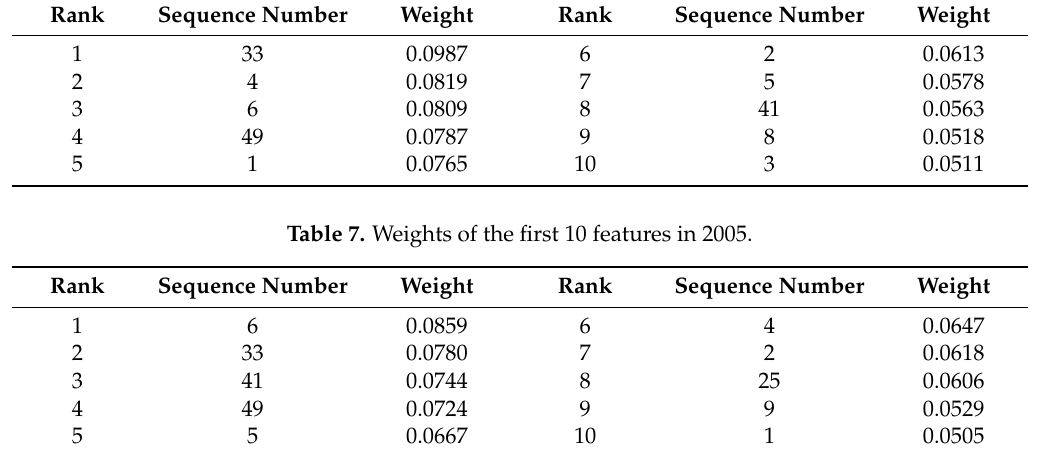
Table 6. Weights of the first 10 features in 2000.